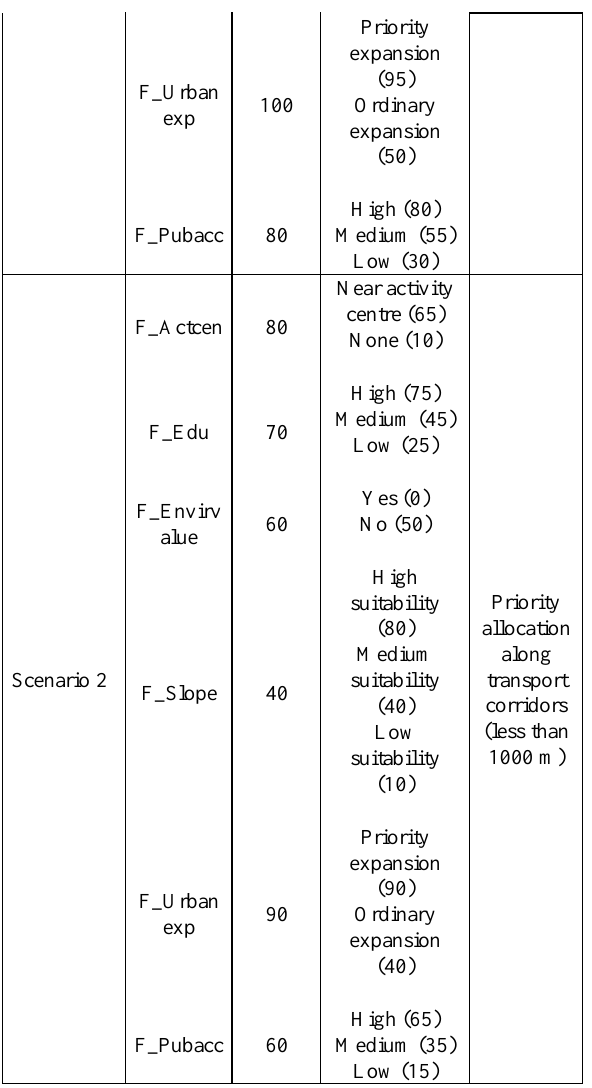
Table 3 . Parameters of constructed scenarios.